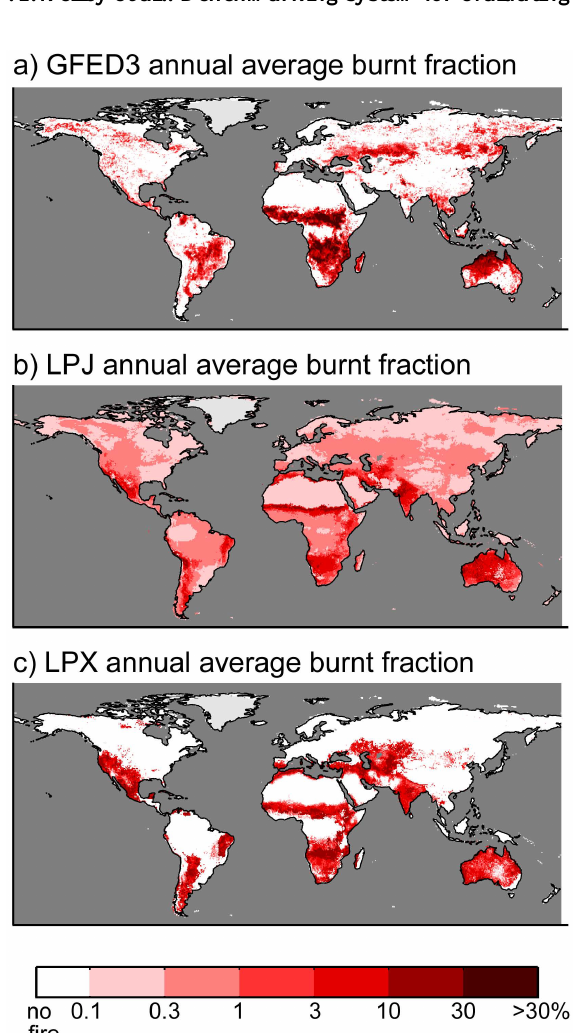
Fig. 7. Annual average burnt fraction between 1997–2005 from (a) GFED3 observations (Giglio et al., 2010) and as simulated by (b) LPJ and (c) LPX.